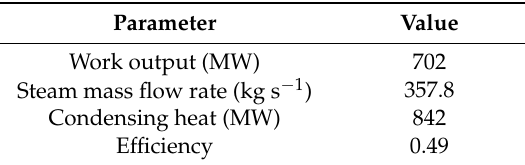
Table 3. Power plant simulation